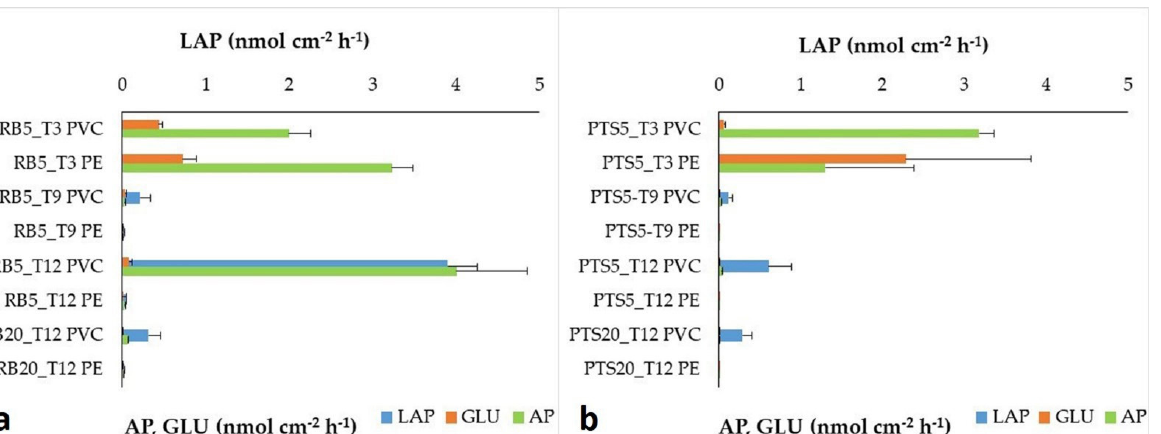
Figure 6. Mean values + standard deviations of enzymatic activity rates (Leucine aminopeptidase, LAP; beta-glucosidase, GLU; alkaline phosphatase, AP) measured in the microbial biofilm devel- oped on plastic materials submerged in the Tethys Bay area at 5 m and 20 m for 12 months (T12). ( a ) AG, Amorphous Glacier (impact station); ( b ), TB, Tethys Bay (control station). PVC: Polyvinyl chloride; PE: Polyethylene.